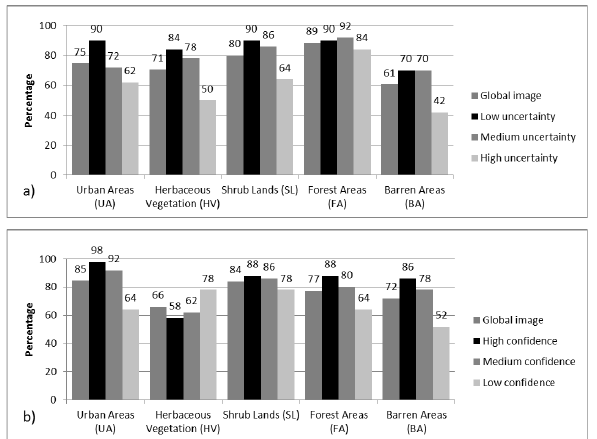
Figure 7. Producer’s accuracy per class of a) the global image and of the regions with low, medium and high uncertainty computed using the RMD, b) the global image and the regions with high, medium and low